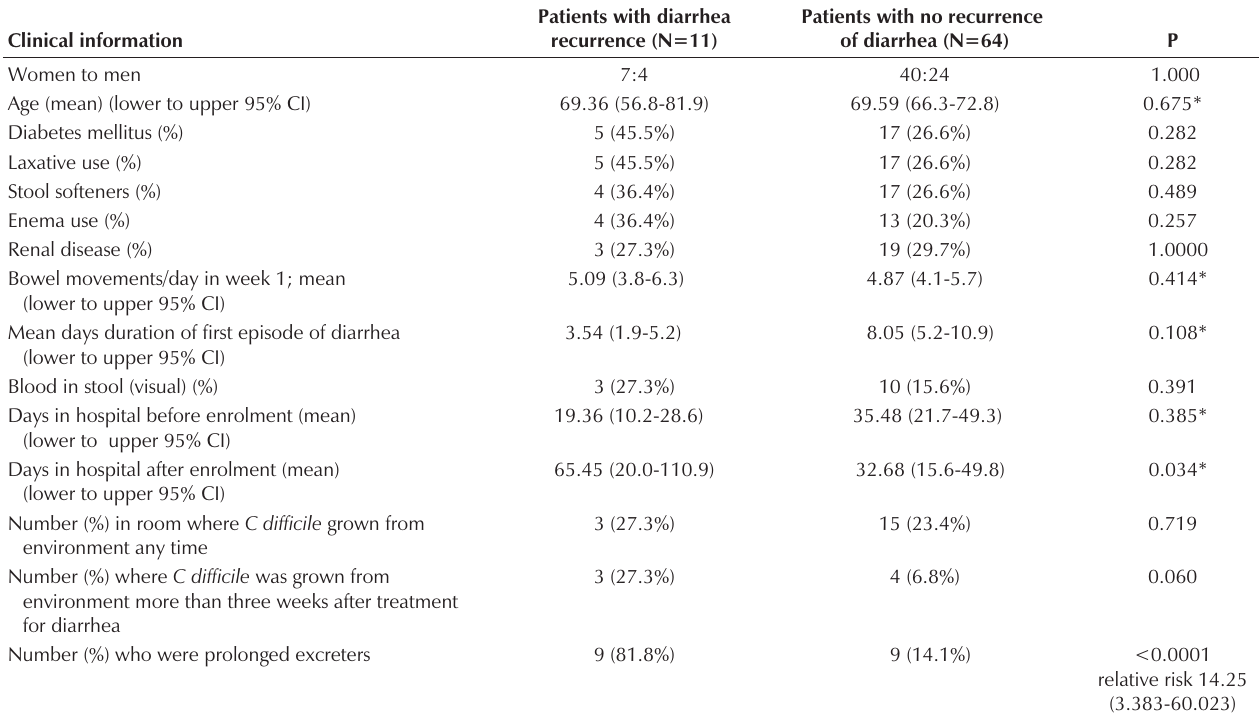
were test positive by one of the diagnostic tests evaluated. Eleven patients had diarrhea recurrence, and 18 of the 75 pa- tients were prolonged excreters. The distribution of diarrhea recurrence stratified by week of hospitalization is shown in Figure 1. Comparative clinical information for diarrhea recur- rence versus nondiarrhea recurrence CAD patients who were prospectively monitored is given in Table 1. The mean age and the ratio of men to women in the two populations were not sig- nificantly different; however, the range of ages was very wide for both groups (Table 1). The majority of patients (93%) treated for CAD received metronidazole. The average length of initial metronidazole therapy was 10.9 (cid:4) 5.3 days and 7.5 (cid:4) 5.9 days for patients with diarrhea recurrence and nondiarrhea recurrence, respectively (not significantly different P=0.08). Thirteen patients were later switched to vancomycin for a number of reasons. To de- termine further whether the antibiotic therapy that these pa- tients received affected on diarrhea recurrences, the time-line of diarrhea and antibiotic use was made (Figure 2). The aver- age time to the first episode of diarrhea reccurence after com- pletion of therapy for CAD (either metronidazole or vancomy- cin) was 11.5 days (range two to 39 days). It was not possible Figure1) Numberofweeksthatpatientswerefollowedinthestudy.Al- to determine whether the two cases of diarrhea recurrence though 75 patients were enrolled in the study, over half were dis- charged by week 3. The distribution of when diarrhea recurrence that occurred while patients were taking their initial metroni- occurred compared with the number of weeks that the patients were in dazole therapy were due to treatment failure. The patients the study is shown by the data at the bottom of the graph. Eleven pa- with diarrhea reccurence (eight of 11, 72.7%) were signifi- tients had diarrhea reocurrence cantly more likely (P=0.022, relative risk 4.0, 95% CI 1.15 to TABLE 1 Clinical information about patients with Clostridium difficile -associated diarrhea studied at St Boniface General Hospital Patients with diarrhea Patients with no recurrence Clinical information recurrence (N=11) of diarrhea